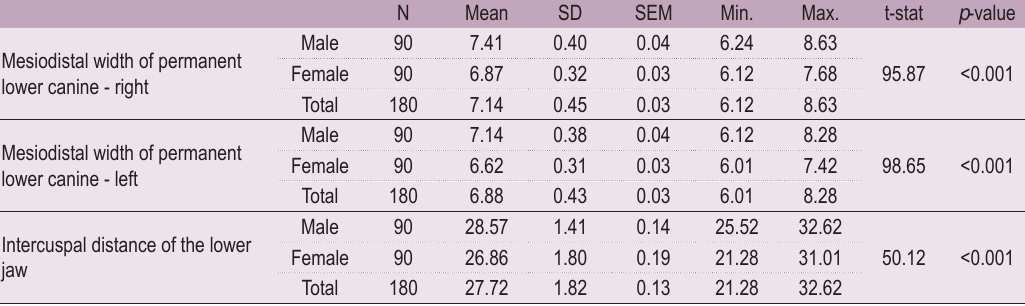
TABLE 1. Parameters of descriptive statistics of analyzed upper and lower jaw variables